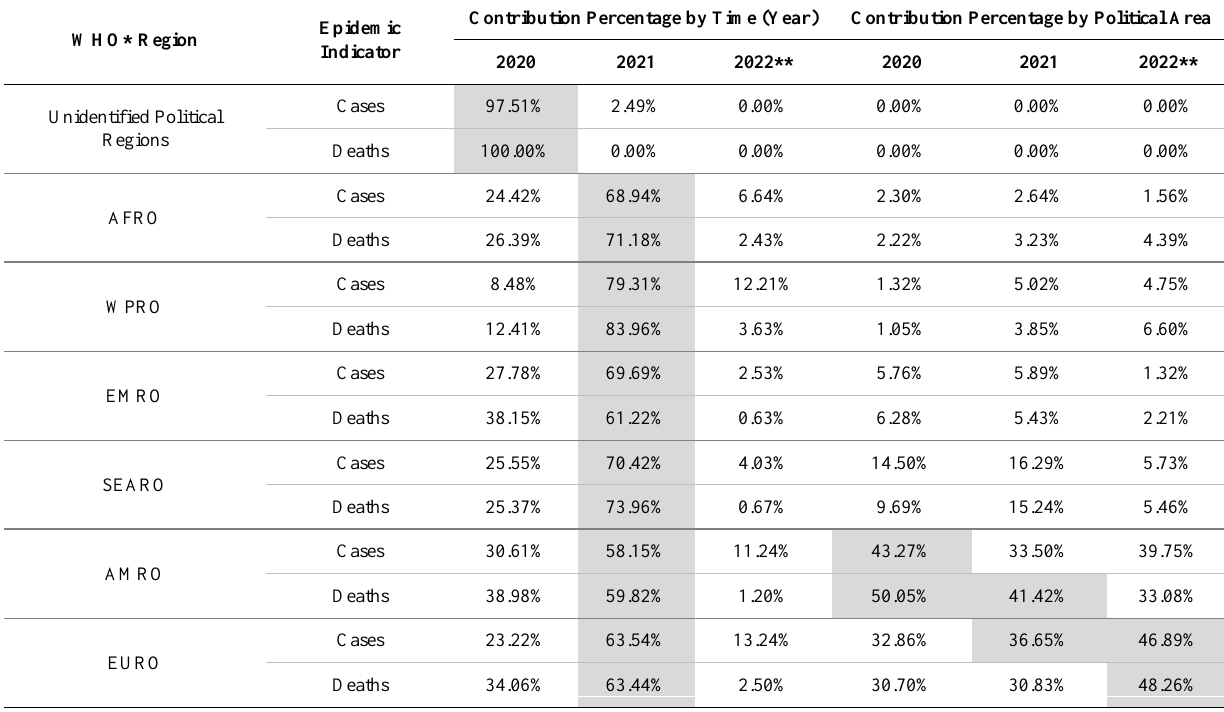
Table 2. Two-dimensional analysis of contributors in COVID-19 morbidity and mortality within WHO political regions based on time (in years) and geopolitical areas Epidemic WHO* Region Indicator Unidentified Political